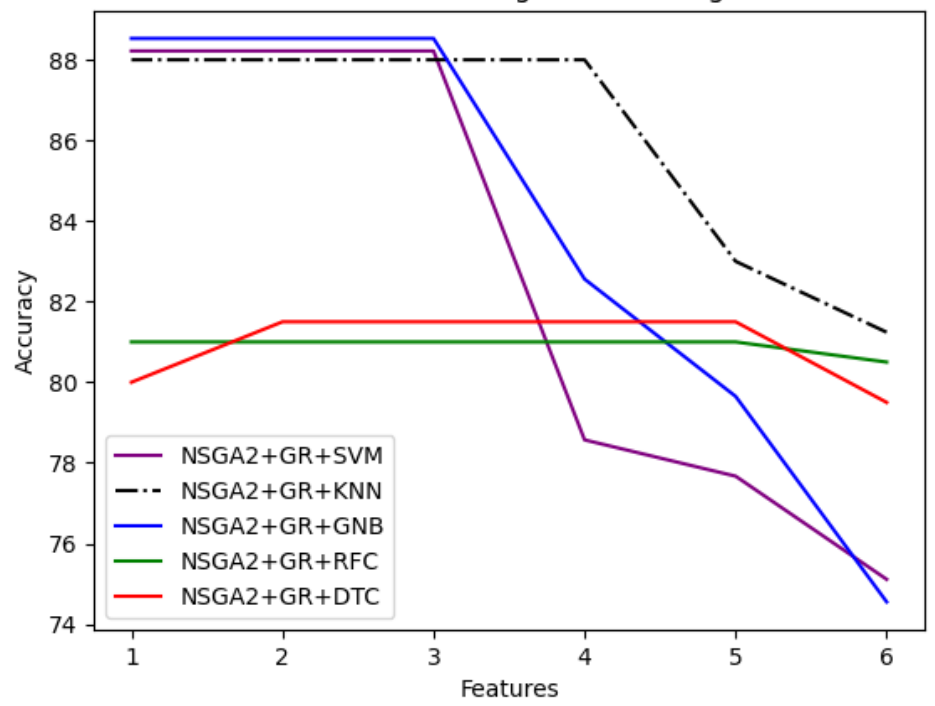
Figure 4. NSGA2 + GR with different classifiers builds using subsets of the IoV vehicle collision detection features.